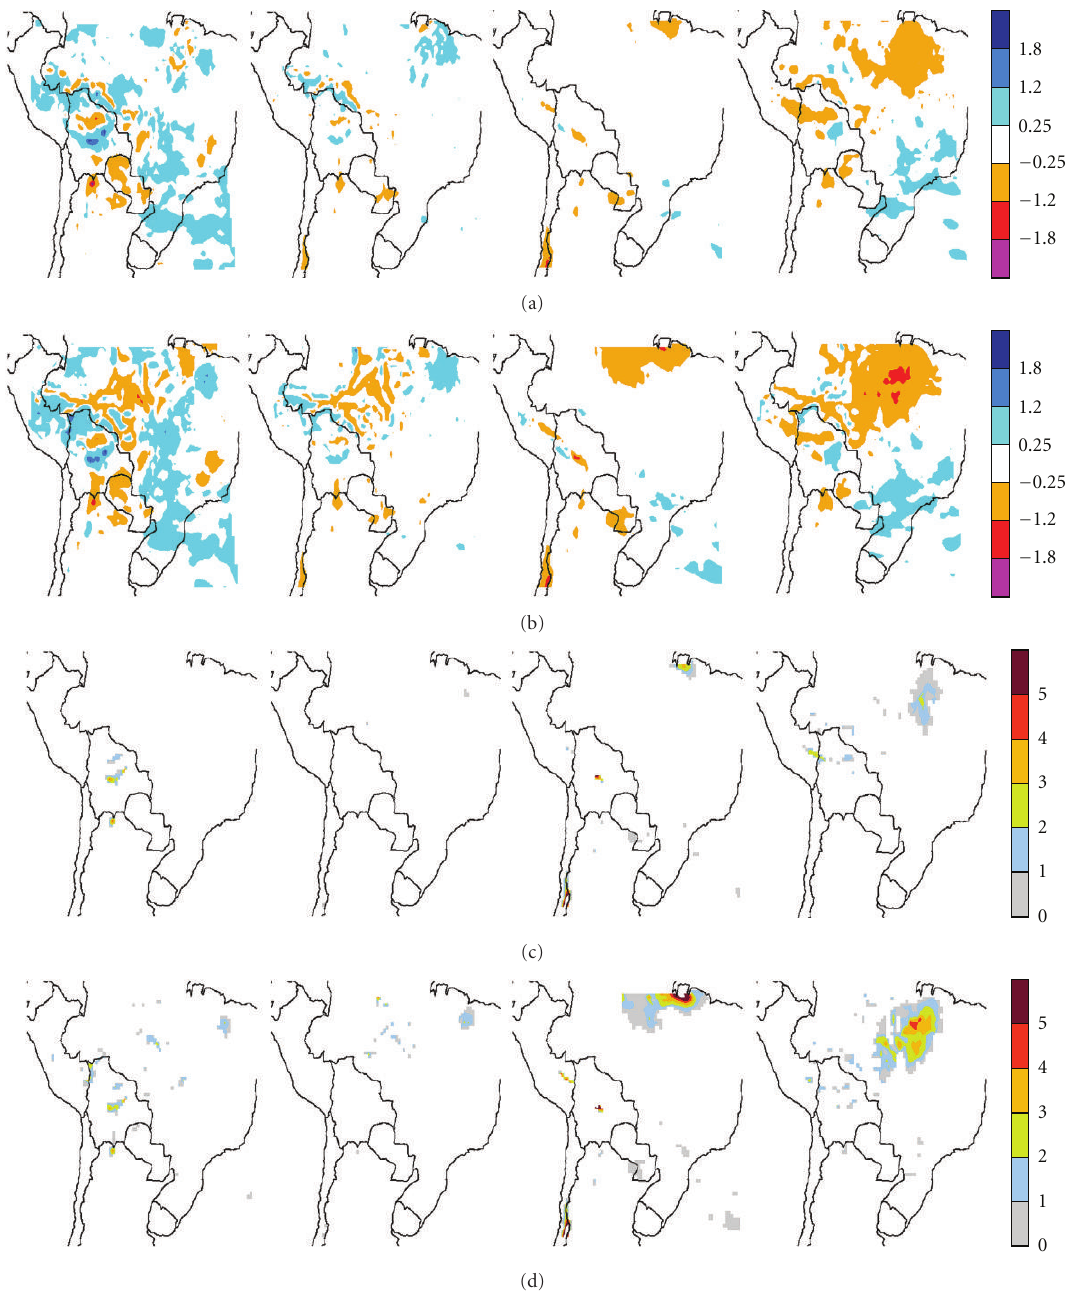
Figure 8: Seasonal precipitation changes, in mmday − 1 , resulting from the two deforestation/land-use scenarios in ECHAM-4 Baseline driven PRECIS runs, for (a) MAP1 and (c) MAP2. The corresponding significances at least at the 90% level are shown in (b) and (d), respectively. Starting from the left the columns correspond to summer (DJF), autumn (MAM), winter (JJA), and spring (SON).